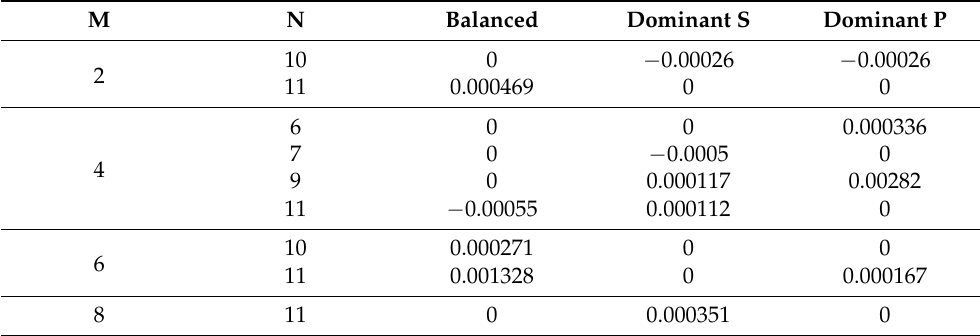
Table 2. Average δ deviation from GA for small